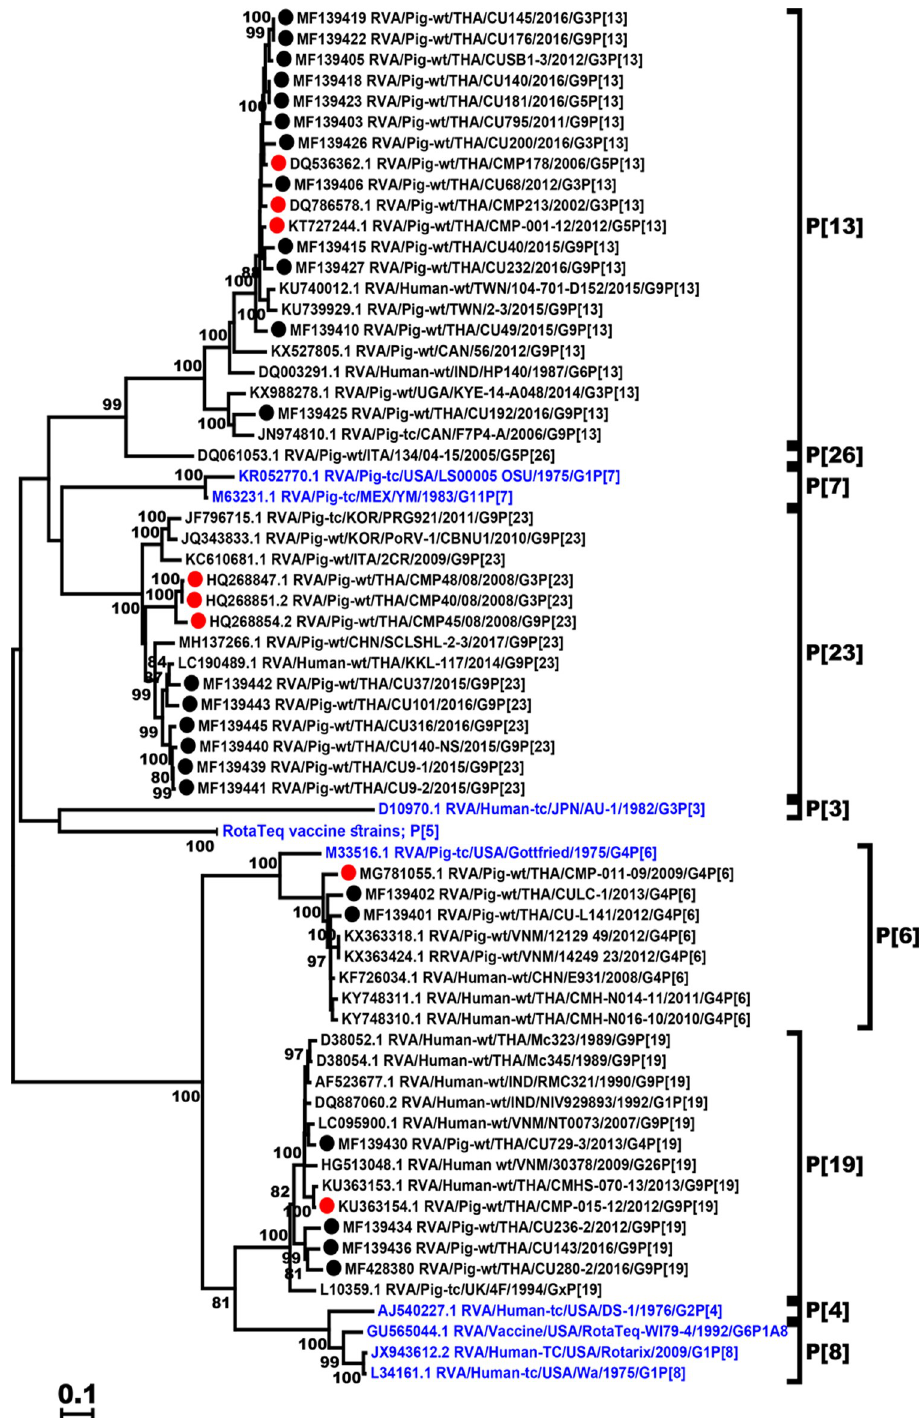
Fig 2. Phylogenetic analysis of the RVA VP4 gene. The nucleotide sequences of the Thai strains (dotted) were compared to those of previous Thai porcine RVA strains (red dotted), the RVA reference and vaccine strains (blue).